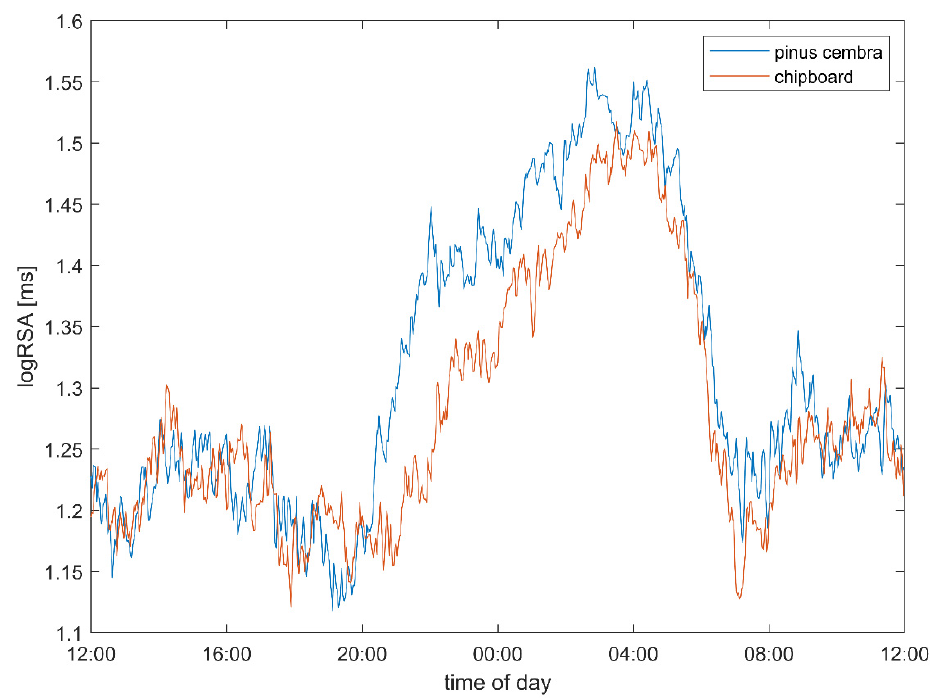
Figure 4. Vagal activity as computed from the respiratory component of HRV (logRSA), when the subjects slept in the stone pine wood beds (blue) and in the chipboard beds (red). Each curve represents the average of nearly 90 nights of measurements for 15 subjects. Like in the heart rate, the strongest difference in vagal activity was found during the first hours of sleep.